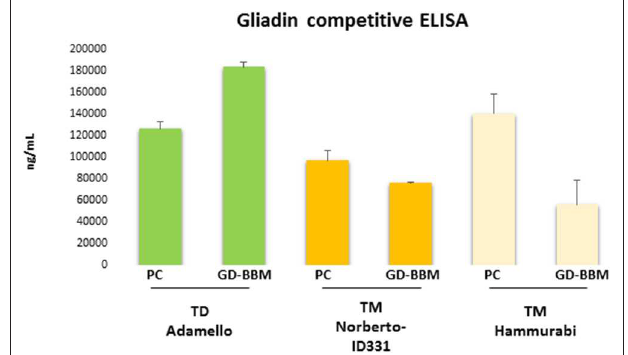
FIGURE 1 | Immunoreactivity of pepsin–chymotrypsin- (PC-) and gastrointestinal and brush border membrane digestion (GD-BBM) (GD-BBM)-digested gliadin measured by competitive ELISA “Gliadin competitive” based on R5 monoclonal antibody of T. monococcum (Norberto-ID331 and Hammurabi cvs ) and T. durum (Adamello cv ). Error bars represent the SD values.